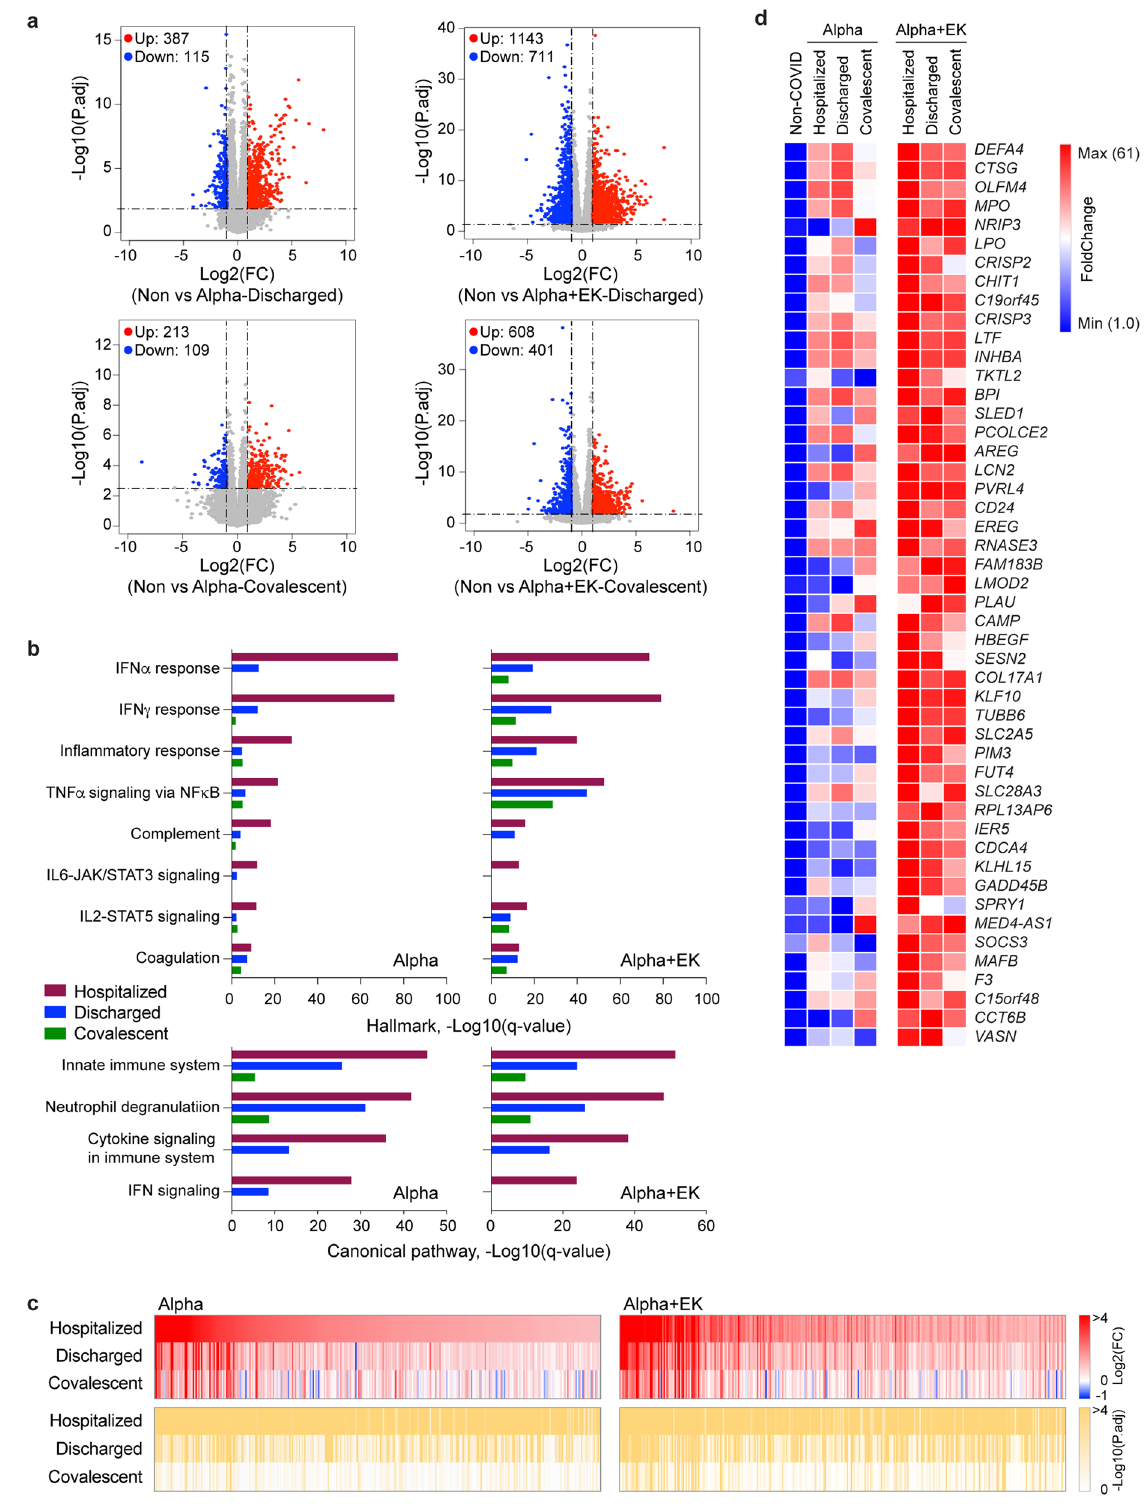
Figure 5. Longitudinal progression of immune transcriptomes from patients infected with the Alpha or Alpha + EK variants. ( a ) Volcano plot of DEGs comparing Non-COVID versus discharged or convalescent of the Alpha and Alpha + EK patients. The numbers of upregulated and downregulated genes are listed. ( b ) Genes expressed at significantly higher levels in the COVID-19 patients were significantly enriched in Hallmark Gene Sets (top) and Canonical Pathway Gene sets (bottom). X-axis denotes statistical significance as measured by minus logarithm of FDR q-values. Y-axis ranked the terms by q values (red bars: Hospitalized, blue bars, Discharged; green, Convalescent). ( c ) Heatmaps showing log2 FC (top) and corresponding P.adj (bottom) of gene sets from ( b ). ( d ) Heatmaps showing relative fold change of 48 signature genes for the E484K